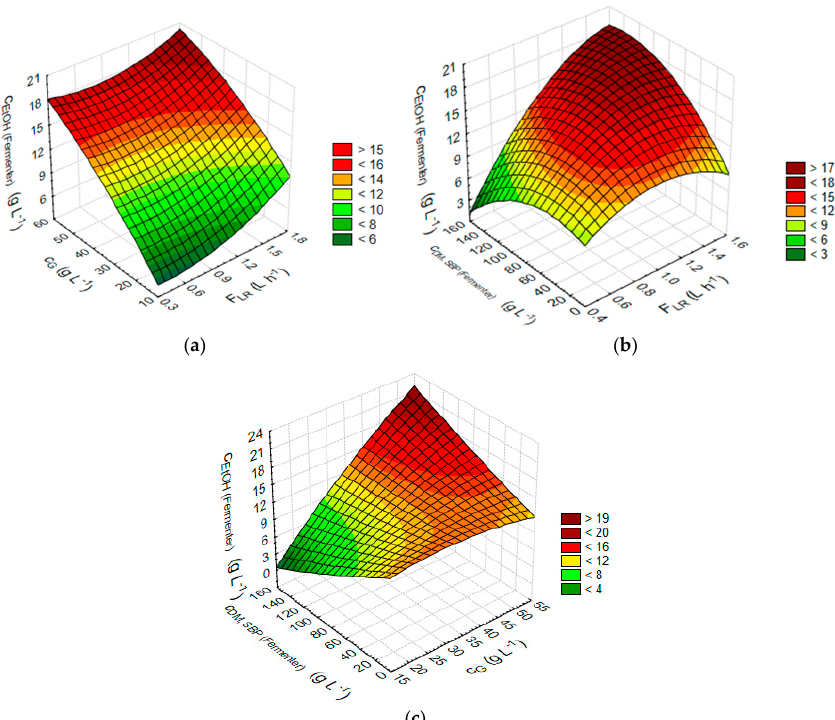
Figure 3. Changes of ethanol concentration in the fermentation step with investigated factors (recycling ratio, solid and carbohydrates concentration) ( a – c ).